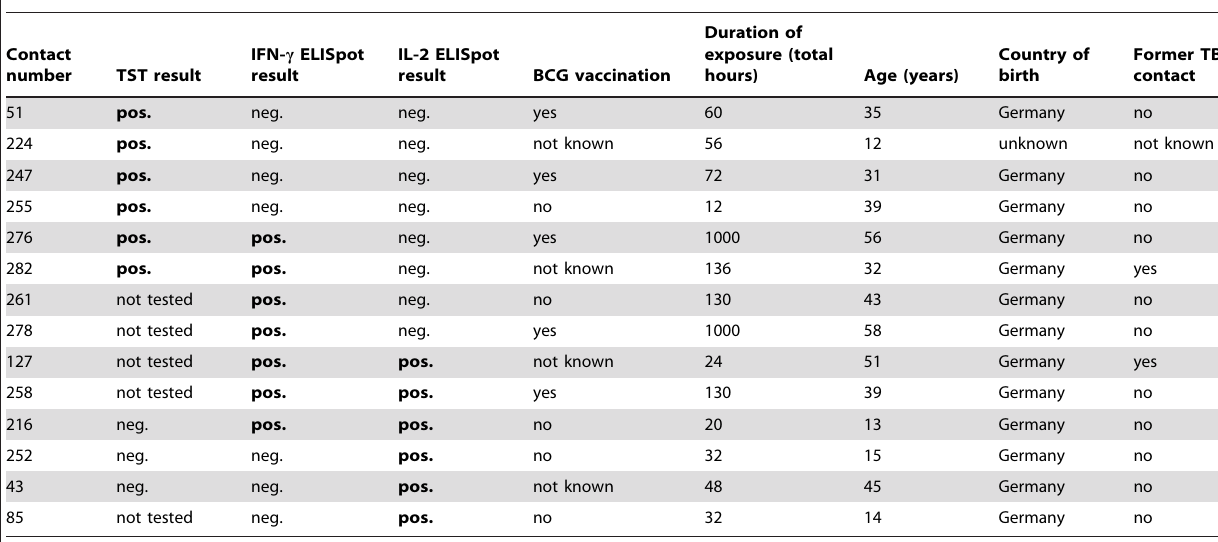
Table 1. Contacts with positive result in at least one of the immunodiagnostic tests.